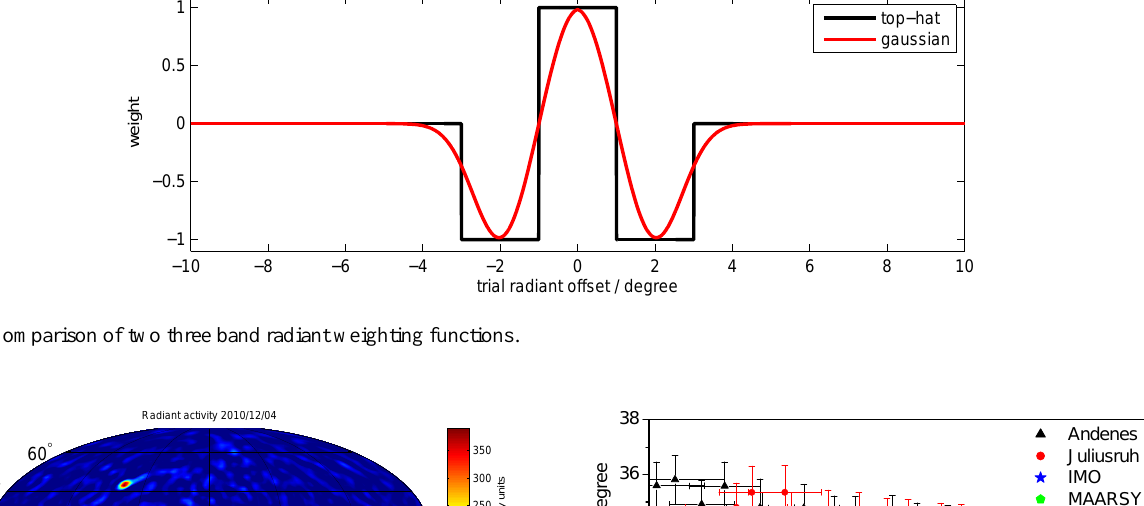
these error bars cannot become smaller than 2 ◦ . The